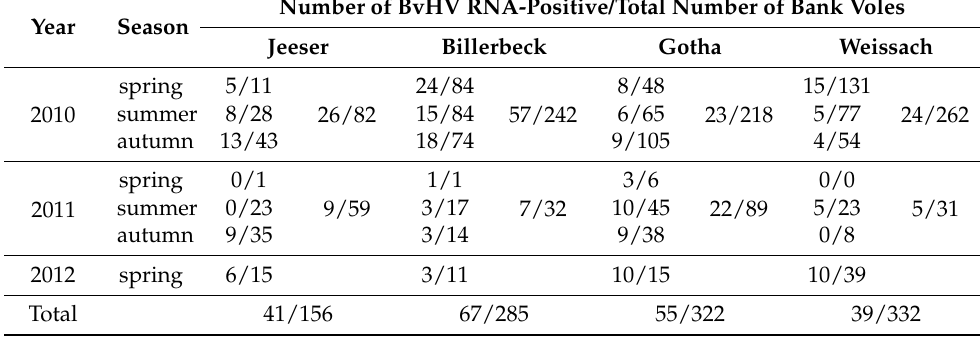
Table 3. Detection of BvHV RNA in bank voles collected at four sites in Germany from 2010 to 2012.